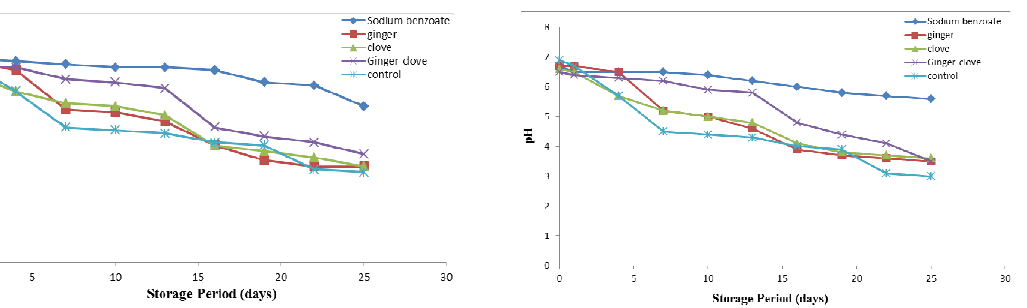
Fig. 7. Effects of different treatments on pH of soymilk samples at 1% concentration stored at refrigerated temperature for 25 days